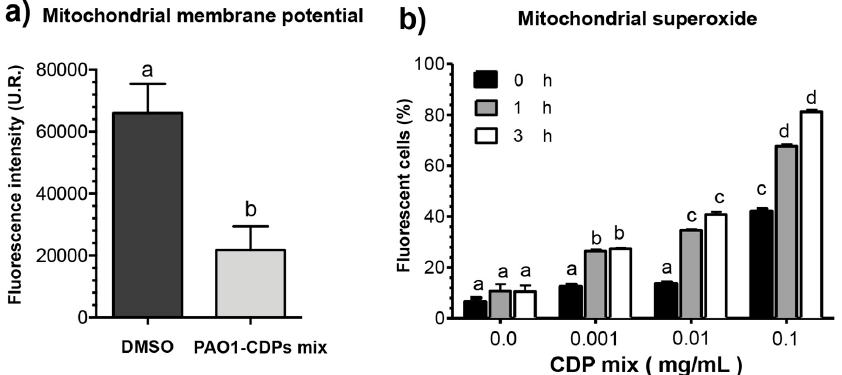
Figure 4. Membrane potential and superoxide quantification in HeLa cells treated with the CDP mixture from P. aeruginosa PAO1. Cell cultures were grown in the CM medium, harvested, and incubated in the CM or SS medium for 2 h. After that, the cell suspensions were incubated with or without PAO1-CDPs for 1 h at 37 °C. At the indicated time points, samples (100 μ L) were resuspended in PBS and mixed with the Rhodamine 123 and DHE probes for quantitation of mitochondrial membrane potential and superoxide, respectively. The samples were incubated for 30 min and washed, and fluorescence was measured in real-time by flow cytometry. ( a ) Mitochondrial membrane potential and ( b ) superoxide quantification as percentage of fluorescent cells. Values are the mean of three independent experiments with 20,000 cells counted by flow cytometry per data point. SEM values are indicated as bars ( n = 3), one-way ANOVA with Tukey’s post hoc test, significant differences ( p < 0.01) are indicated by different lowercase letters.